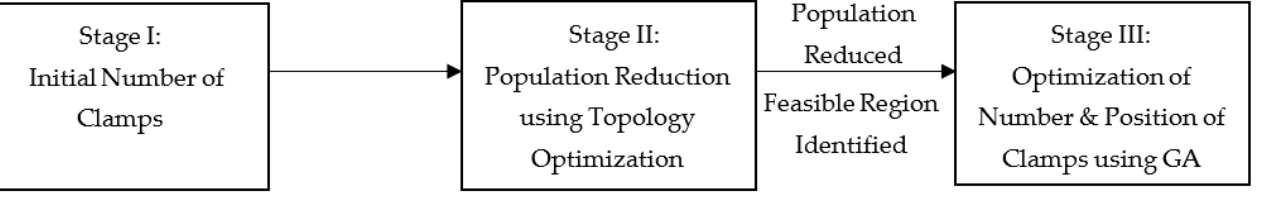
Figure 1. General procedure of proposed method.